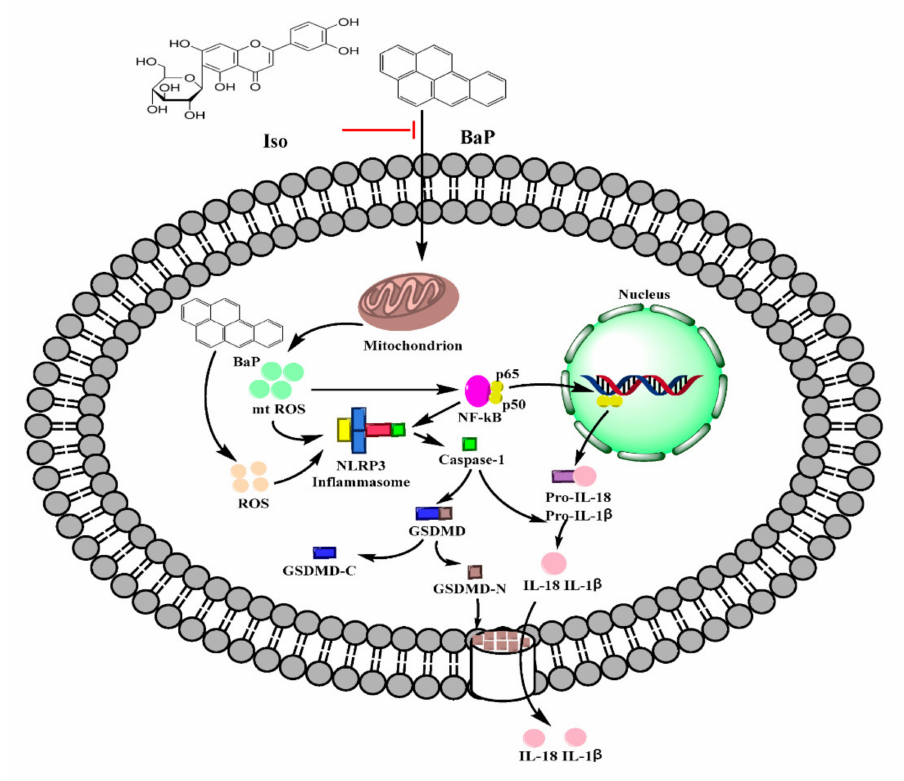
Figure 8. Possible molecular mechanism of Iso on the pyroptotic hepatocyte damage induced by BaP in HL-7702 liver